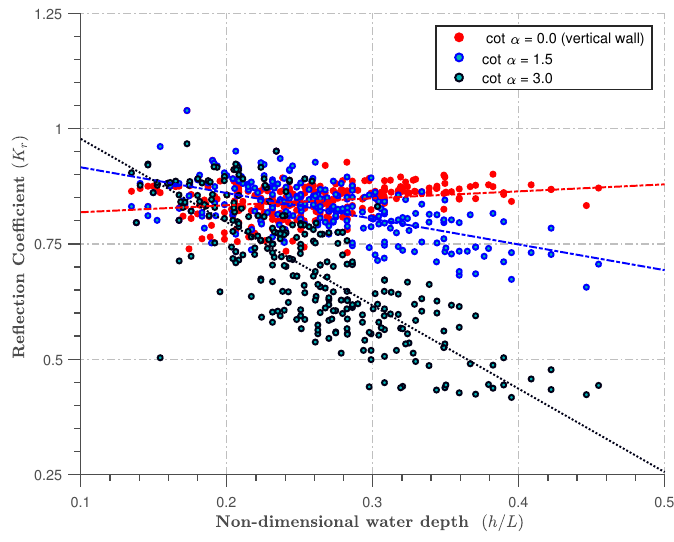
Figure 6. Variations of the reflection coefficient K r with non-dimensional water depth h / L across the three different slopes investigated.